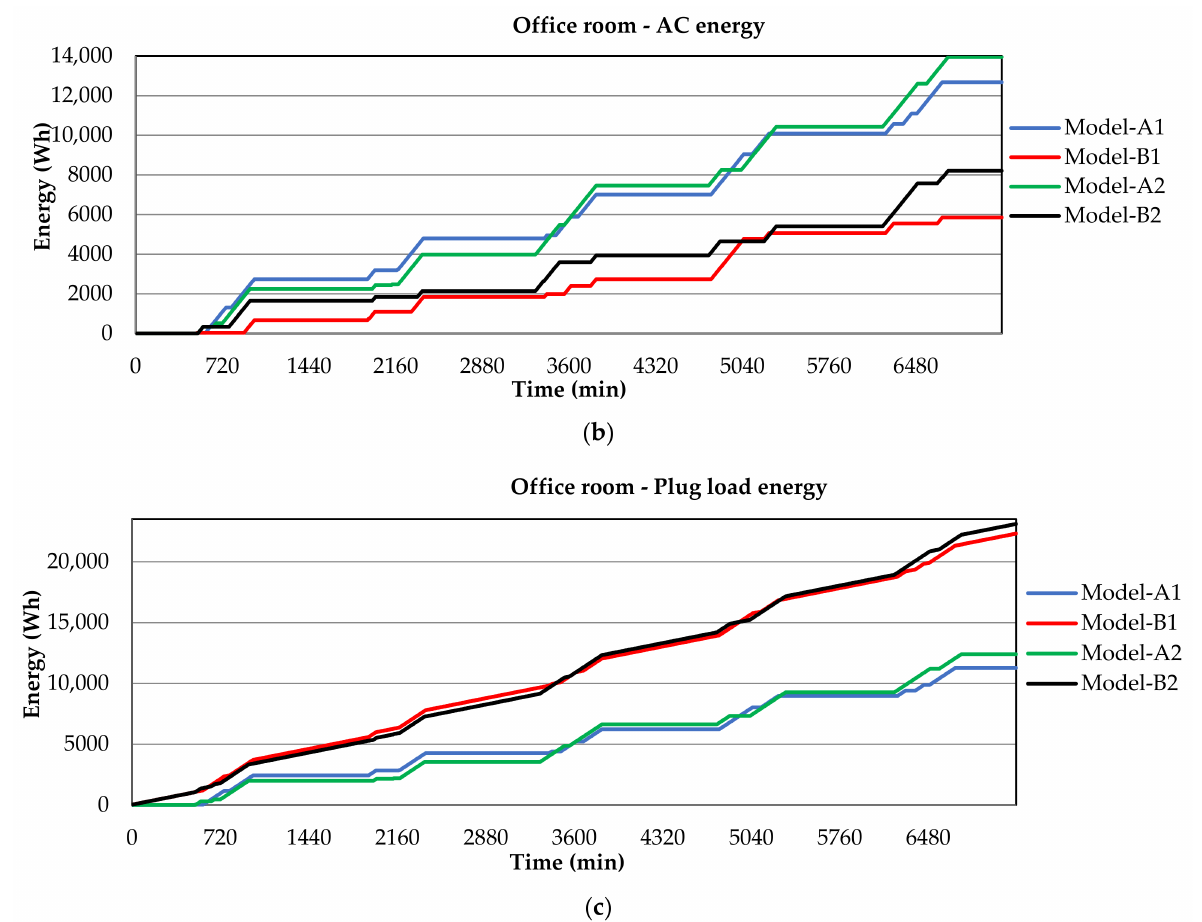
Figure 13. Profile of energy consumption in the Office room: ( a ) lighting energy; ( b ) AC energy; ( c ) plug load energy.